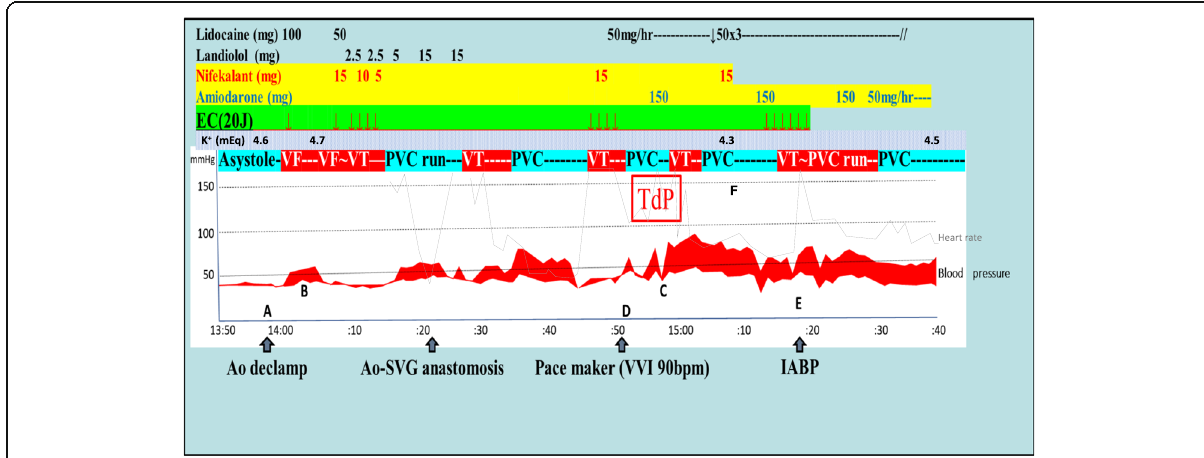
Fig. 1 Treatment details for refractory ventricular arrhythmias occurred after aortic declamp. EC, electrical cardioversion; VF, ventricular fibrillation; VT, ventricular tachycardia; PVC, premature ventricular contraction; PVC run, three or more consecutive PVCs; TdP, torsades de pointes; Ao, aorta; SVG, saphenous vein graft; IABP, intra-aortic balloon